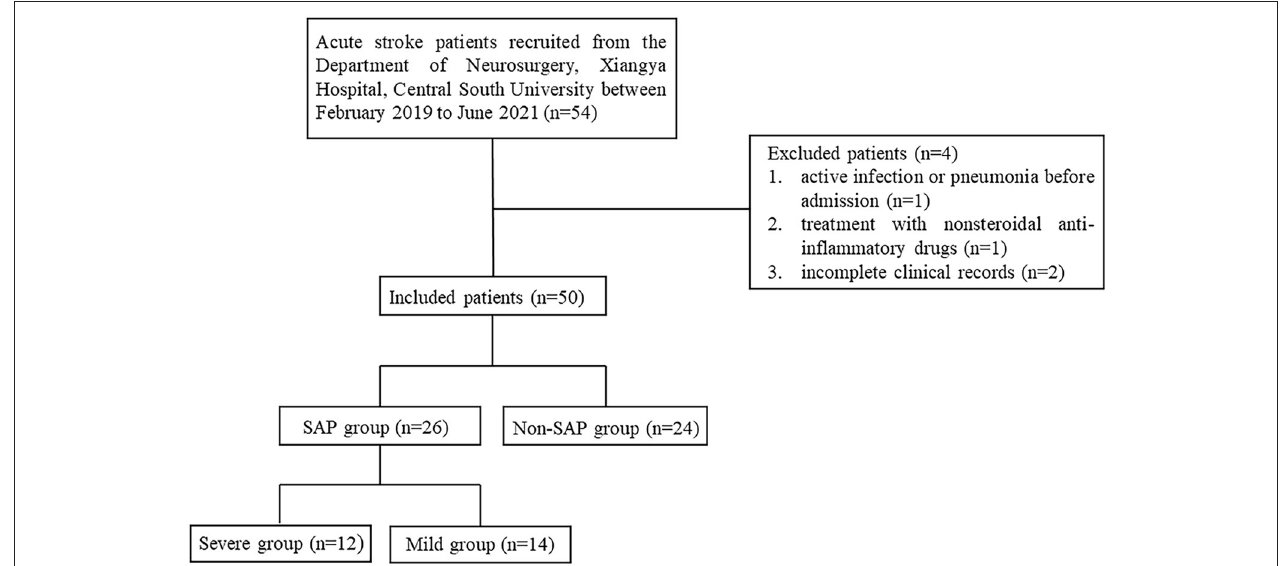
FIGURE 1 | Flowchart of case recruitment. SAP, stroke-associated pneumonia; PSI, pneumonia severity index.